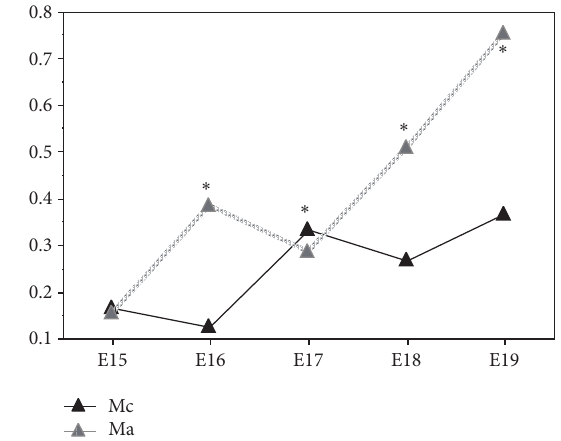
FaFc F 4: Lung retinyl palmitate in the female of control (Fc) and vitamin A (Fa) groups (ng/ g protein), from developmental days g protein), from developmental days E15 to E19 statistically signi�cant). E15 to E19 ( statistically 0.003 and SE ; 𝜇𝜇 ∗ 𝜇𝜇 ∗ 𝑃𝑃 𝑃 0.0001 𝑃𝑃 𝑃 0.0001 ≤ = 0.001